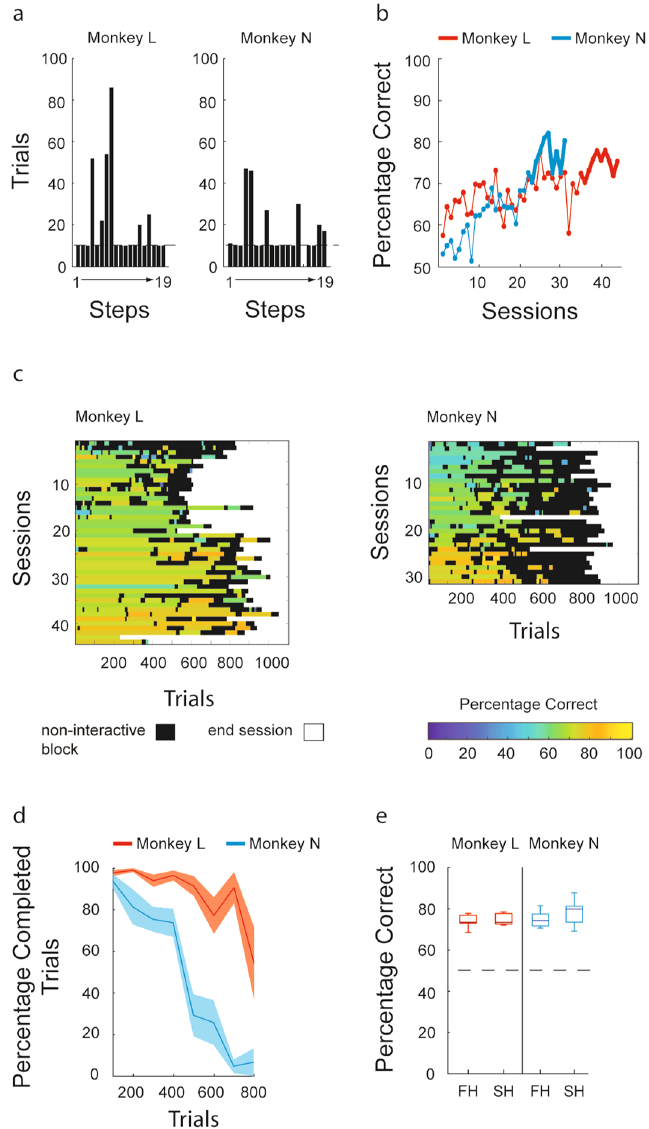
Figure 2. Behavioral results of experiment 1. ( a ) Results of phase 1 and correct response rate of phase 2. Bars represent the number of trials performed to complete a step that was presented for the first time during phase 1. Dashed lines indicate the minimum number of trials required to reach the next step. ( b ) Learning curves for both monkeys. The curves show the percentage of correct choices for each session during phase 2 (44 sessions for monkey L and 31 for monkey N). The thick lines represent the 10 consecutive sessions in which the monkeys reached a correct response rate of above 70% (where a correct response rate of 50% corresponds to chance). ( c ) Working blocks. Each row represents a session during phase 2. Colored lines indicate working blocks, which comprise completed trials (see “Experimental procedures” section). The color bar indicates the correct response rate calculated for each working block. Black lines indicate the non-interactive blocks, which comprise trials in which the monkeys did not interact with the touchscreen. The white area indicates the end of the sessions. ( d ) Stability of interaction within phase 2 sessions. The curves indicate the mean percentage of complete trials (see experimental procedures) calculated using a moving window of 100 trials in sessions in which the learning criterion was achieved and which included at least 800 trials. Color-shaded regions represent the standard error of the mean. ( e ) Stability of performance within phase 2 sessions. Correct response rate for sessions in which the learning criterion was achieved and which included at least 800 trials. The sessions are split into two halves: first half (FH) and second half (SH). The central line represents the median and the top and bottom borders of each box represent the 25th (p25) and 75th (p75) percentiles of the two groups of trials. The whiskers represent the range from 1.5 times the interquartile range above p75 (p75 + 1.5 [p75 − p25]) and below p25 (p25 − 1.5 [p75 − p25]). Data points outside this range are plotted individually (red crosses). The dashed line indicates 50%, the level associated with responses dictated by chance